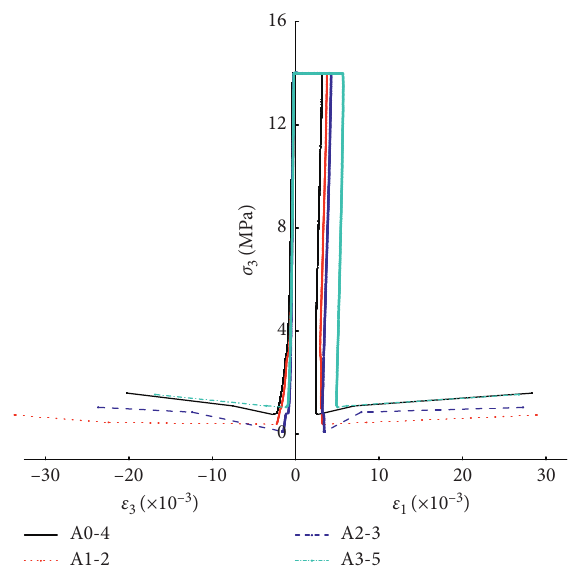
Figure 9: Variation of strains during circumferential